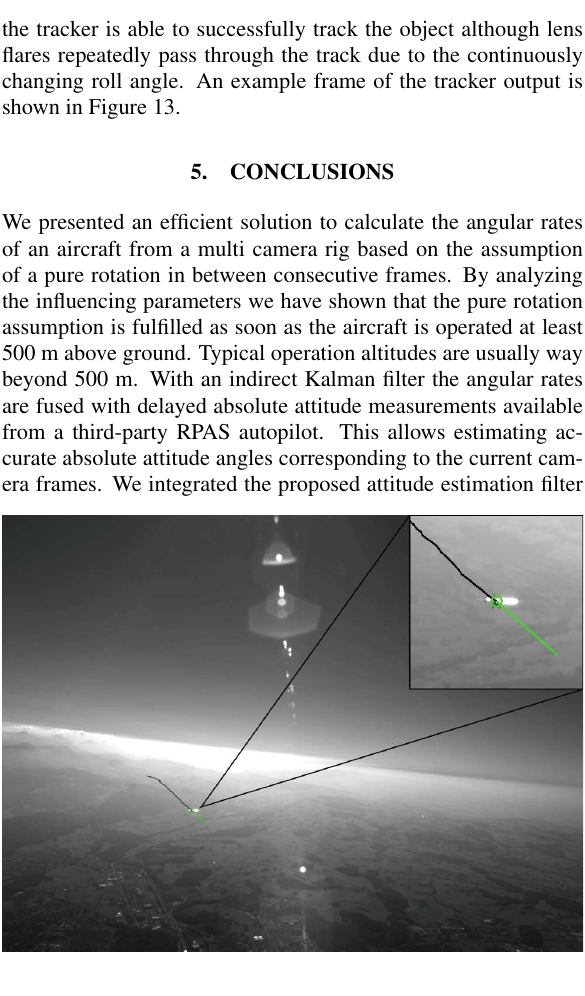
Figure 12: Example frames from Scenario N and P with disabled (AEF off) and enabled (AEF on) attitude estimation filter. Multi- ple tracks are created if the AEF is disabled because new detec- tions are mapped to wrong positions on the tracking sphere (best viewed in